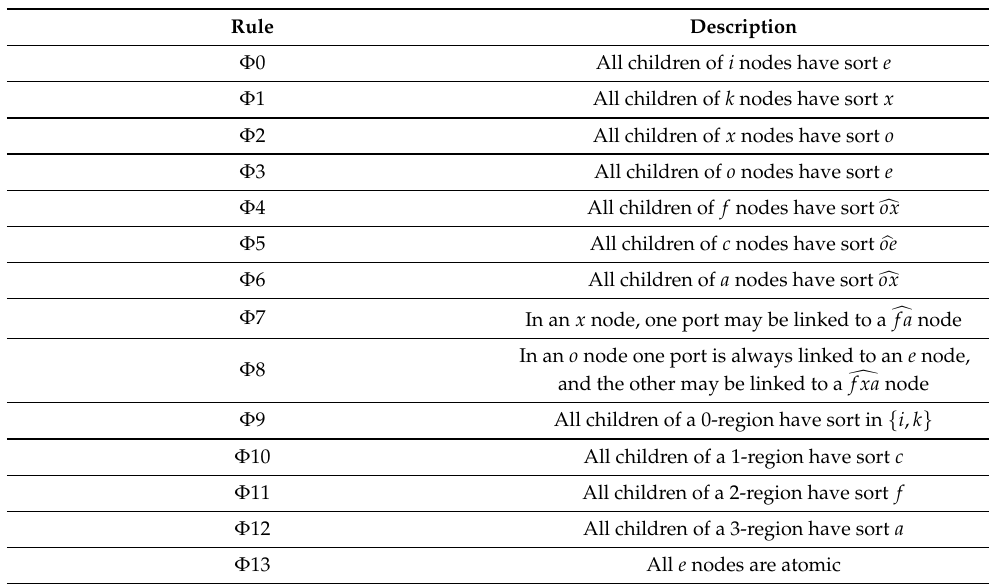
Table 4. Formation rules Φ for B F